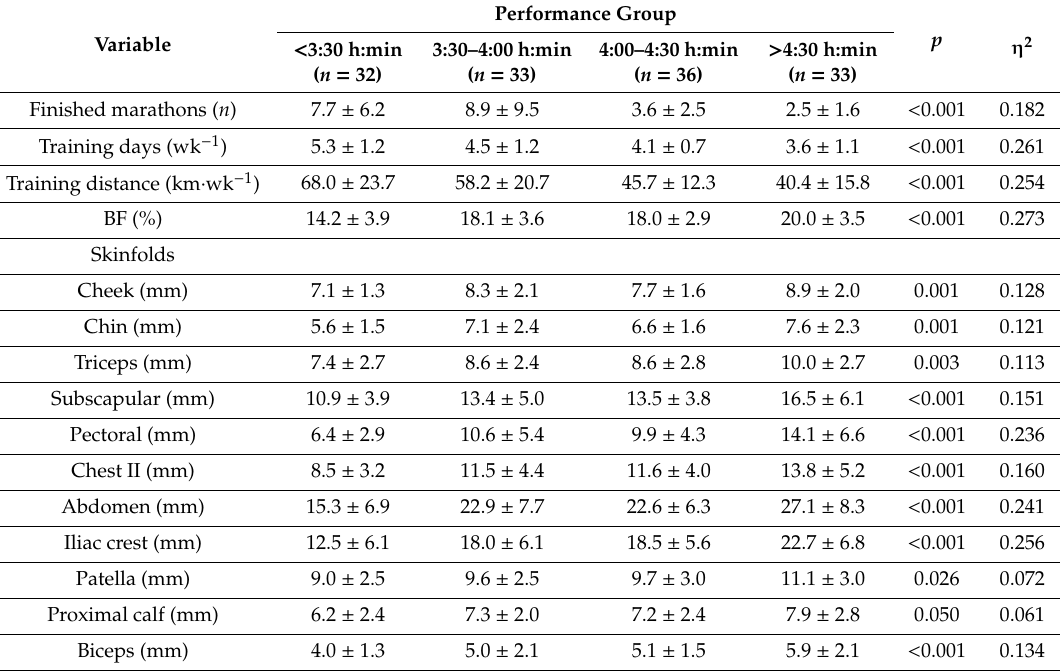
Table 4. Anthropometric characteristics and body composition of male participants by performance